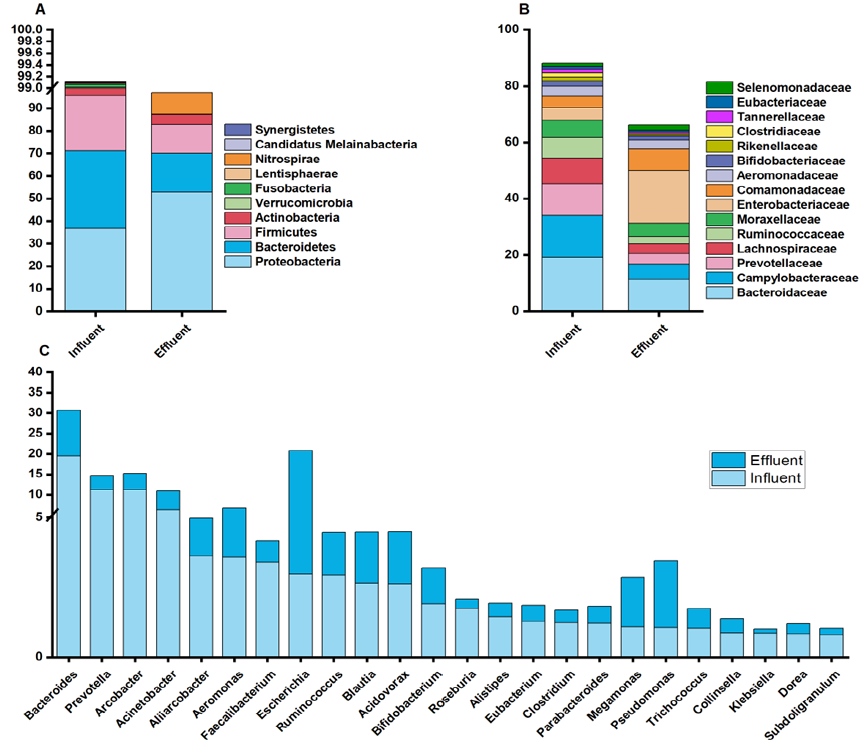
Figure 2. Metagenomics analysis of bacterial communities in influent and effluent, visualized by Origin 2022. The top 10 abundant phyla ( A ); the top 15 abundant families ( B ); and the top 24 abundant genera ( C ). Relative abundance is expressed as a percentage of the total valid sequences for each sample for each bacterial taxonomic units.